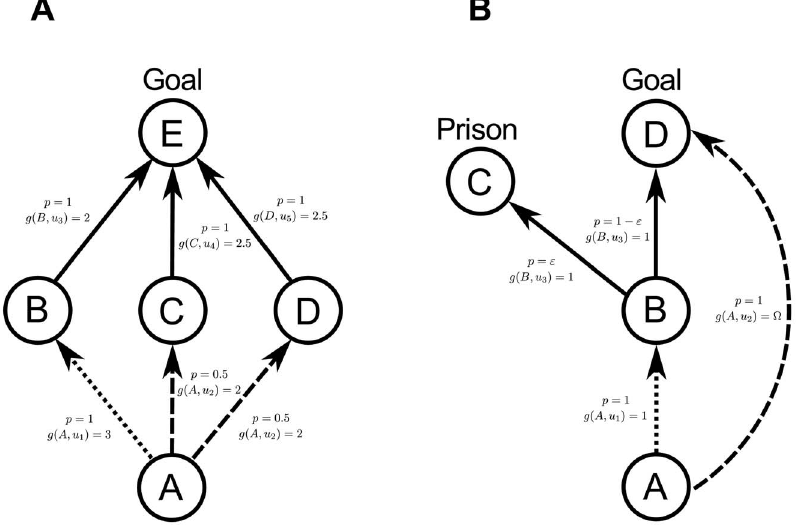
Figure 2. Simple systems where the quasimetric and the dynamic programming methods are not equivalent. (A) Example of non deterministic systems where the quasi-distance differs from the value function.Arrows indicate possible actions with their associated transition probabilities p and costs. Dotted arrow represents action u 1 and dashed arrows action u 2 , both allowed in state A . (B) Example with a prison state C . Starting from A to the goal D we can choose between two actions. Action u 1 in dotted leads to B with a low cost but then with the risk to fall from B to C with a probability p ~ e . B is a risky state. Action u 2 in dashed leads to the goal with a probability p ~ 1 but with a high cost V .